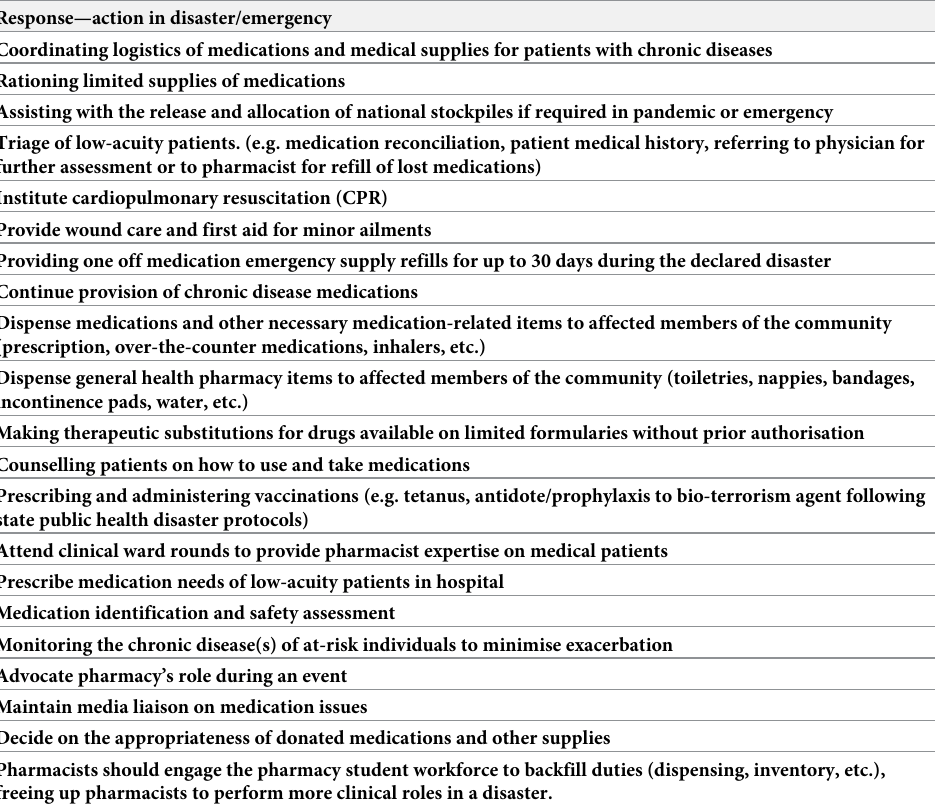
Table 4. Final Consensus on 21 roles pharmacists are capable of undertaking in the response phase of a disaster. Response—action in